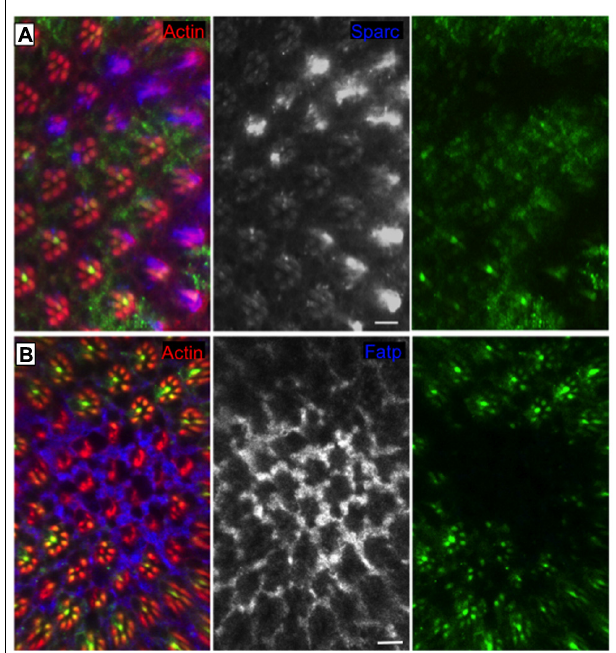
FIGURE 2 | RIDD “in action” in the Drosophila eye. Clones of cells homozygous for Ire1 mutant chromosome ( PBac{WH}Ire1 f02170 ) are labeled by the absence of myrGFP.The protein levels of (A) Sparc (blue and monochrome) and (B) Fatp (blue and monochrome) are elevated in Ire1 mutant tissue, in comparison with the surrounding control tissue. Sparc and Fatp are two RIDD substrates in the Drosophila eye. Actin is in red. Scale bars represent 10 μ m. Adapted from Coelho etal.